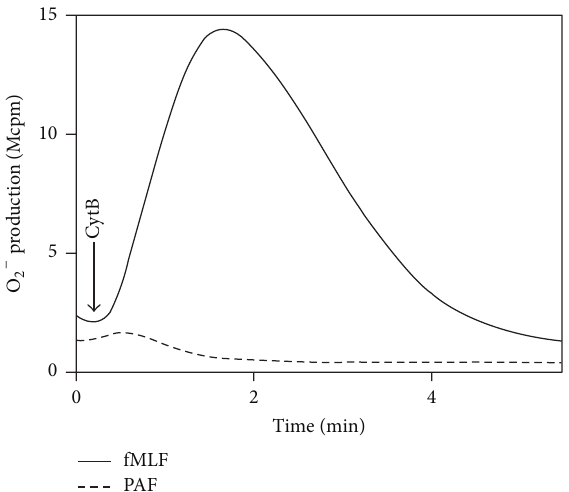
Figure 6: The desensitized PAFR is not reactivated by CytB. Neutrophil was desensitized with fMLF (100nM; FPR1 agonist, solid line) or PAF (100nM; PAFR agonist, dashed line) at 15 ∘ C for 10min. The cells were then transferred to 37 ∘ C, and the incubation was continued for another 10min. The cells were then challenged with CytB (5 𝜇 g/mL, added at the time point indicated by arrow), and reactivation of the receptor was determined through the release of superoxide. One representative experiment out of three is shown. Abscissa: time of study (min); ordinate, superoxide production expessed as counts per minute × 10 6